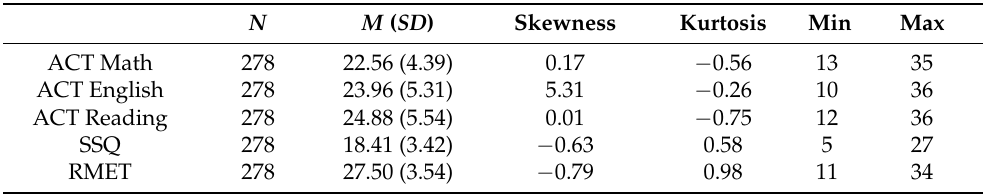
Table 1. Descriptive Statistics.